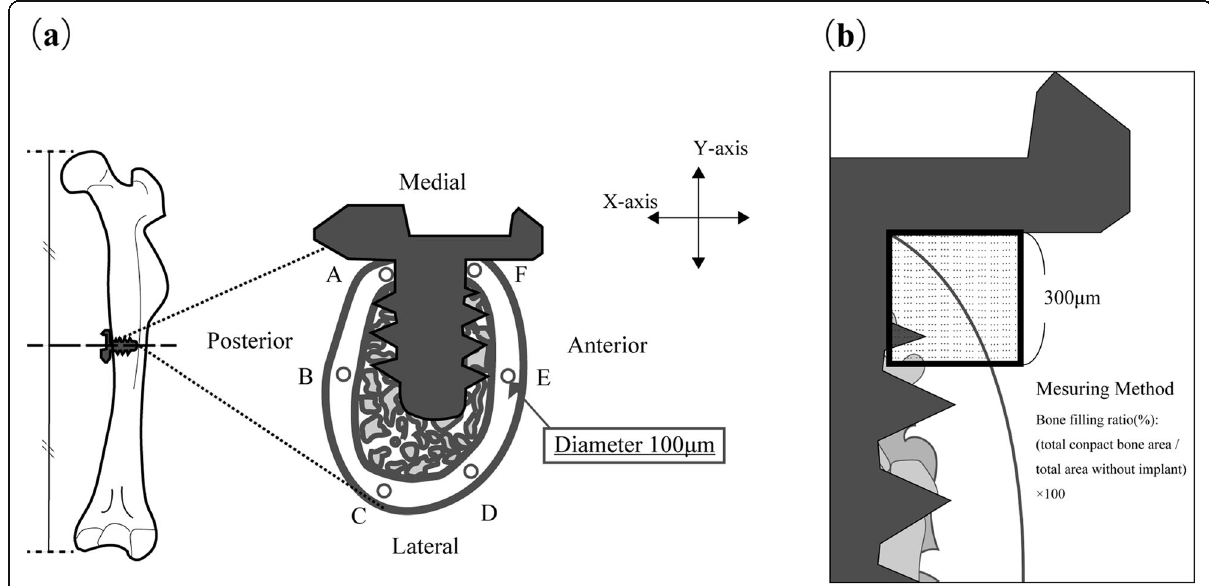
Fig. 5 Method of setting region of interest and evaluating new bone mass surrounding the implant. a The region of interest was the cortical bone region on a 100 μ m polished specimen created in the XY plane that passes through the center of the implant body. The measurement points were classified as follows: A, F: peri-implant area. B, C, D, E: normal area. b To evaluate the amount of new bone surrounding the implant, the value obtained by dividing the area occupied by calcified bone in the 300 μ m square shown in the figure by the total area excluding the implant was shown as a